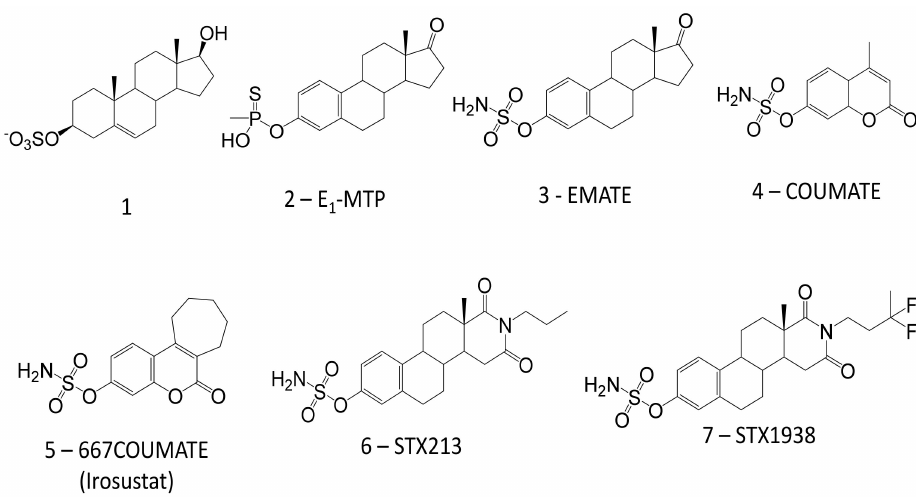
Figure 2. The structure of selected STS